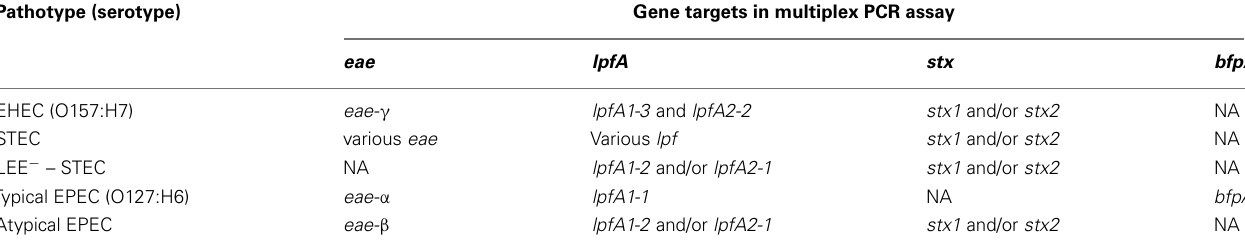
Table 2 | Gene profiles for differentiation of E. coli